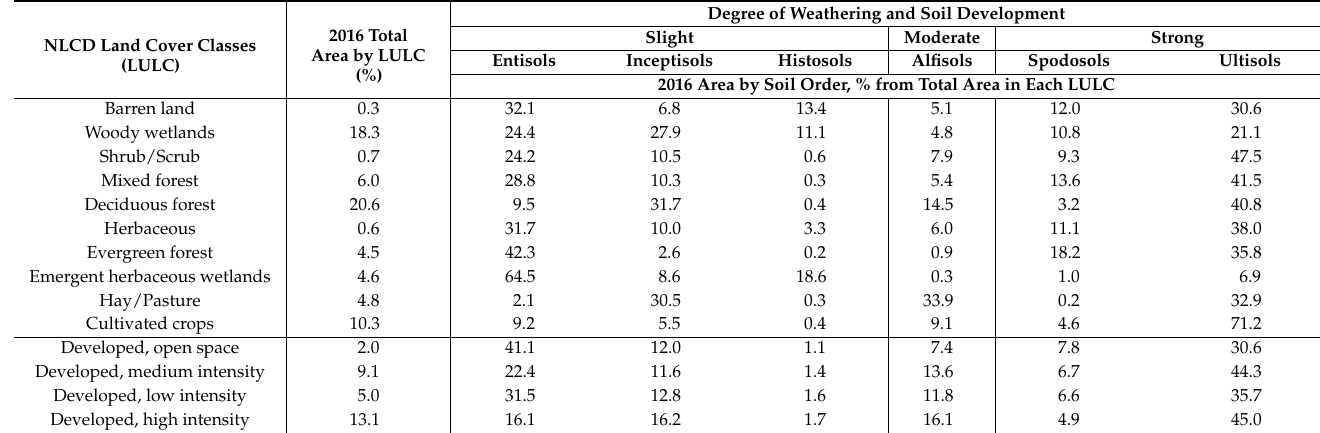
Table 13. Land use/land cover (LULC) by soil order in New Jersey (USA) in 2016. Degree of Weathering and Soil Development 2016 Total Slight Moderate Strong NLCD Land Cover Classes Area by LULC Entisols Inceptisols Histosols Alfisols Spodosols Ultisols (LULC) (%) 2016 Area by Soil Order, % from Total Area in Each LULC Barren land